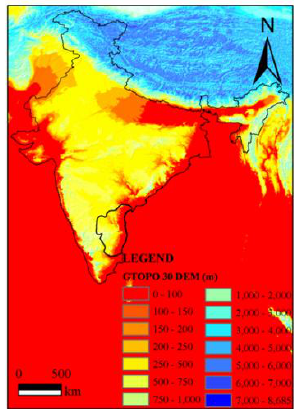
Figure 3 DEM and boundary file for VIC